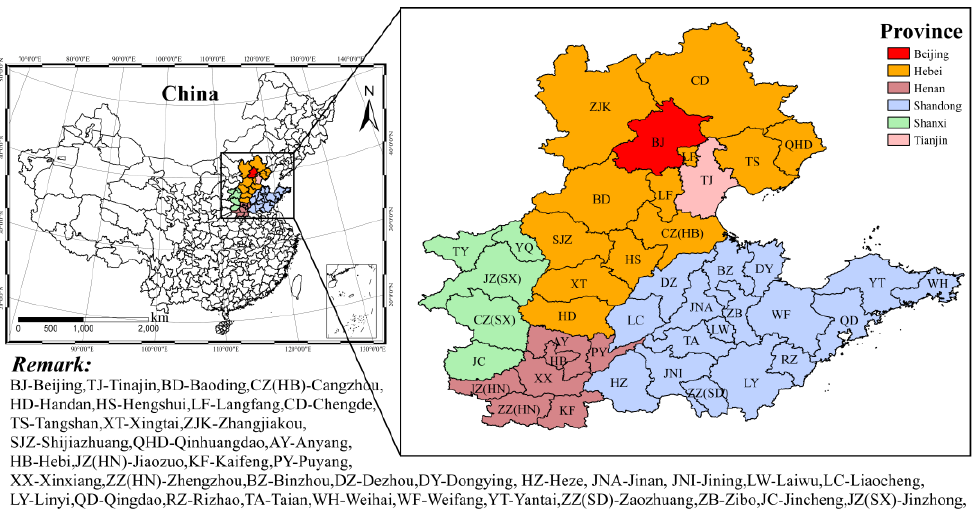
Figure 1. The study domain and cities in the northern part of the North China Plain (NNCP) re- gion.